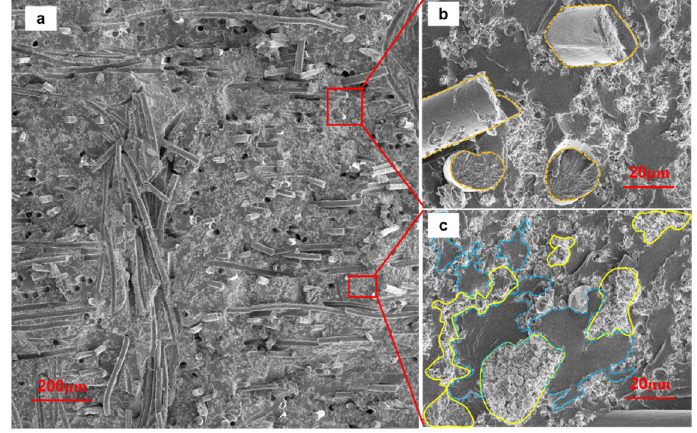
Figure 4. Morphology of the hydrophobic A-CF/EP/PEF surface ( a ), the combination of carbon fiber and EP/FEP resin ( b ), and incorporation between EP and FEP ( c ). Table 1 . Water contact angle (WCA) of M-CF/EP composites with 4% PU and different contents of FEP.